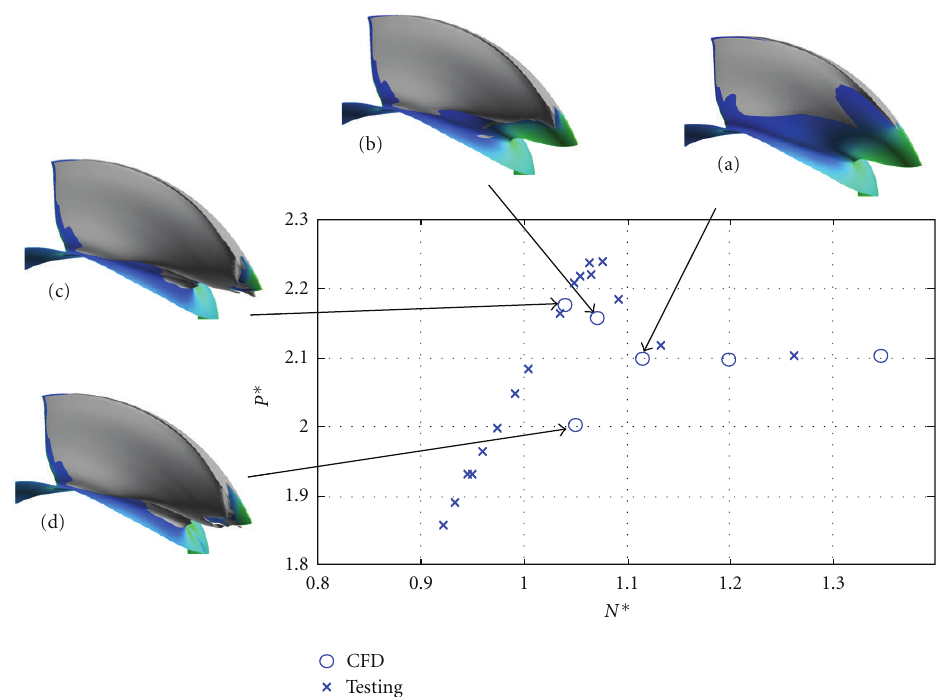
Figure 8: Computational results, breakdown at nominal flow rate, Q ∗ = 0 . 825. Experimental results, flow at roughly constant Q ∗ = 0 . 825 for N ∗ > 1 . 1 but flow rate decreases at lower values of N ∗ . Illustrations from CFD results at each of four points, (a) ( N ∗ = 1 . 1149) (b) ( N ∗ = 1 . 0699) (c) ( N ∗ = 1 . 0392) (d) ( N ∗ = 1 . 0497), prior to and after breakdown. Isosurface of vapor volume fraction equal to 0.5 illustrates extent of cavitation along the suction surface of the rotor blade at each of the four